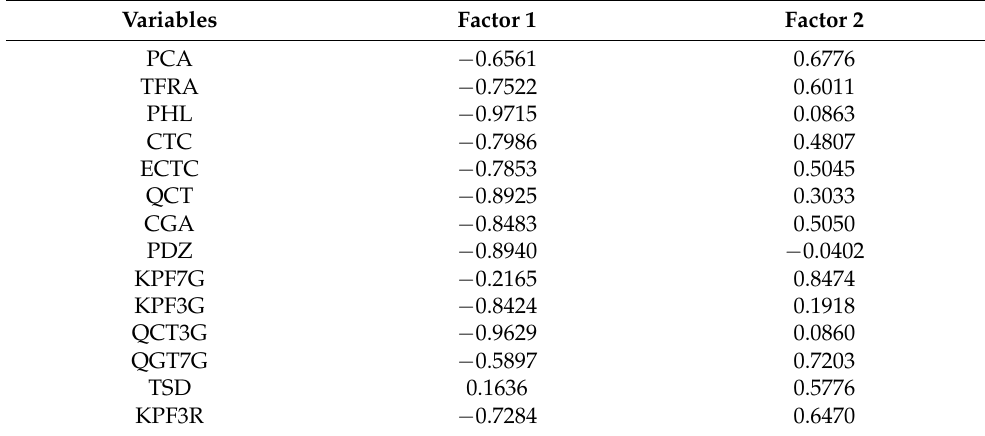
produced by the UHPLC-MS/MS on six cocoa